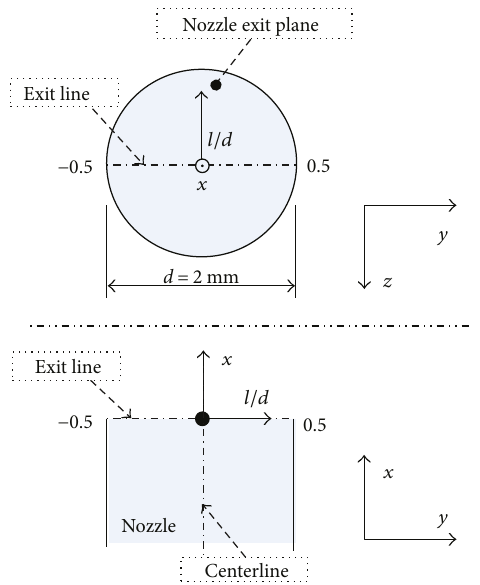
Figure 7: Radial location of simulated jet velocity across the nozzle exit plane.